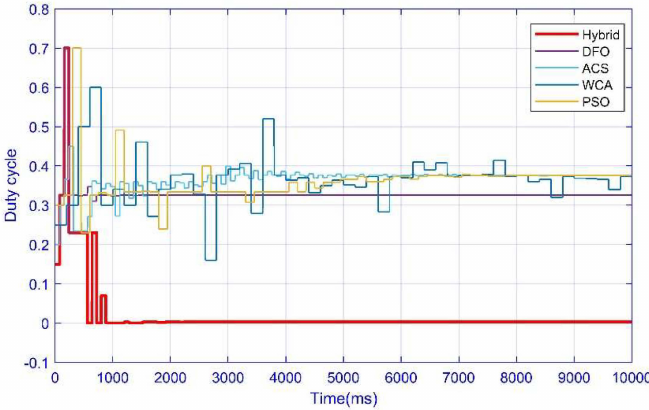
Figure 12. Case 3: Duty cycle comparison of hybrid with other techniques.